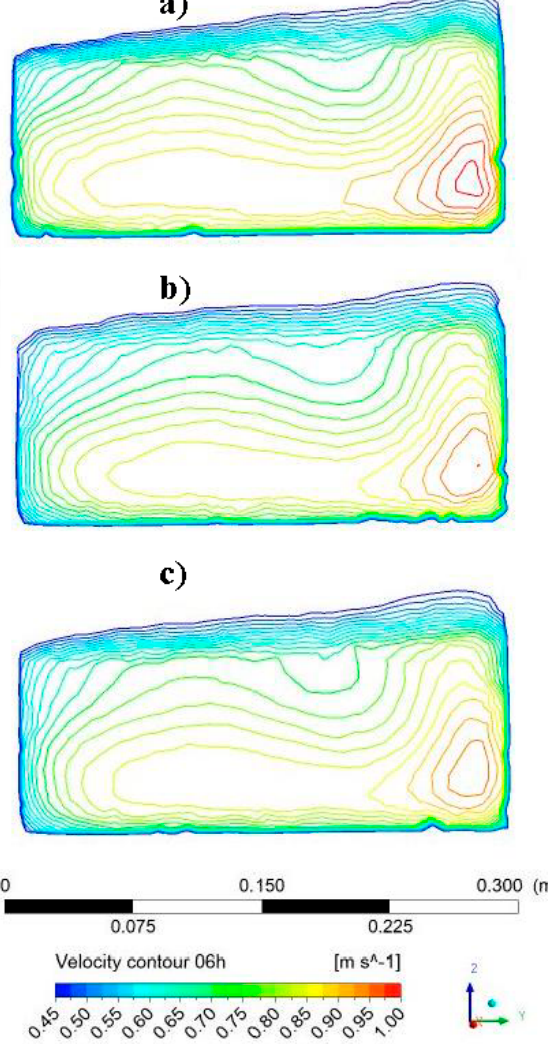
Figure 8. Velocity contours of “without vane” situation for Sections; ( a ) 1-1 ( b ) 2-2 ( c ) 3-3.